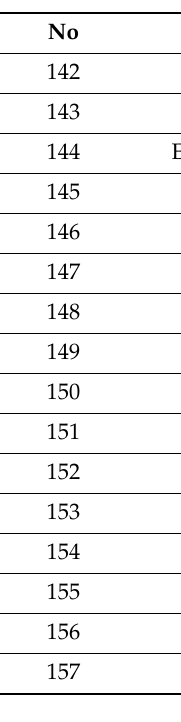
Table 4. Main components of volatile oils of Kaempferia species.